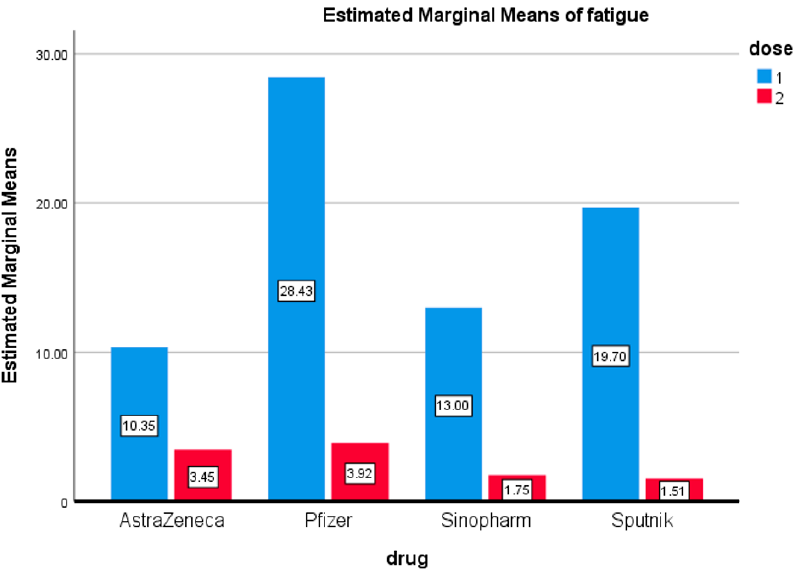
Figure 7. Fatigue. Estimated marginal means of fatigue after first and second doses of vaccines used in the Kingdom of Bahrain.